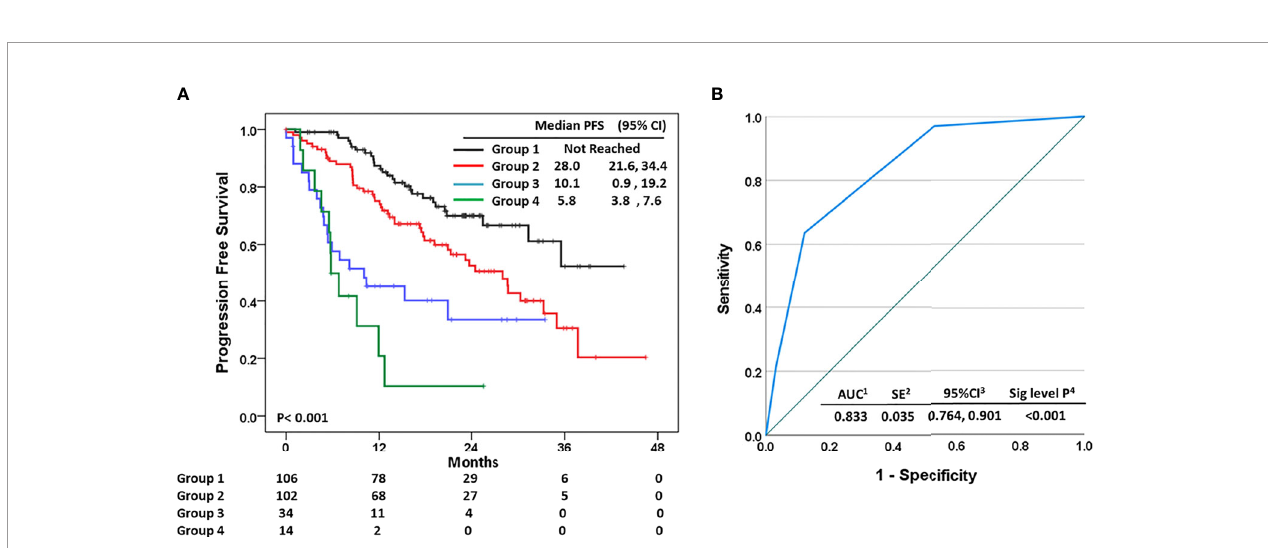
FIGURE 6 | (A) Progression-free survival according to the risk groups of the prediction model. (B) Receiver operating characteristic curve for primary resistance to palbociclib with letrozole as the fi rst-line treatment for HR+ HER2- MBC regarding the risk